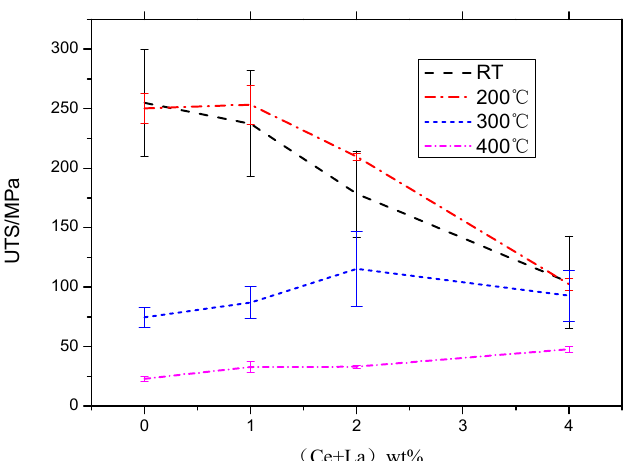
Figure 7. Ultimate Tensile Strength (UTS) from the tensile tests as a function of the (Ce and La) additions.